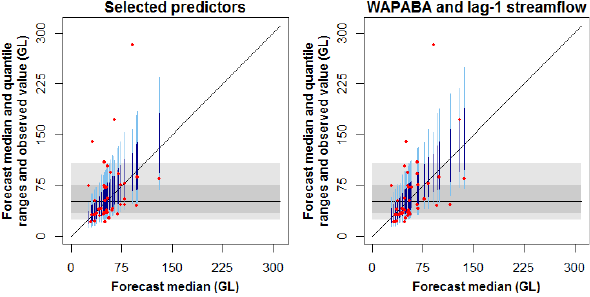
Fig. 7. Forecasts of Kiewa River inflows into the Murray River for the March-April-May season. Using selected predictors, RM- SEP skill score=9% and CRPS skill score=1%, using WA- PABA simulations and lag-1 streamflow as predictors RMSEP skill score=18%, and CRPS skill score=10%. (1:1 line, forecast me- dian; dark blue vertical line, forecast [0.25, 0.75] quantile range; light and dark blue vertical line, forecast [0.10, 0.90] quantile range; dark grey horizontal line, climatological median; mid-gray shade, climatological [0.25, 0.75] quantile range; light and mid-gray shade, climatological [0.10, 0.90] quantile range; red dot, observed catch- ment